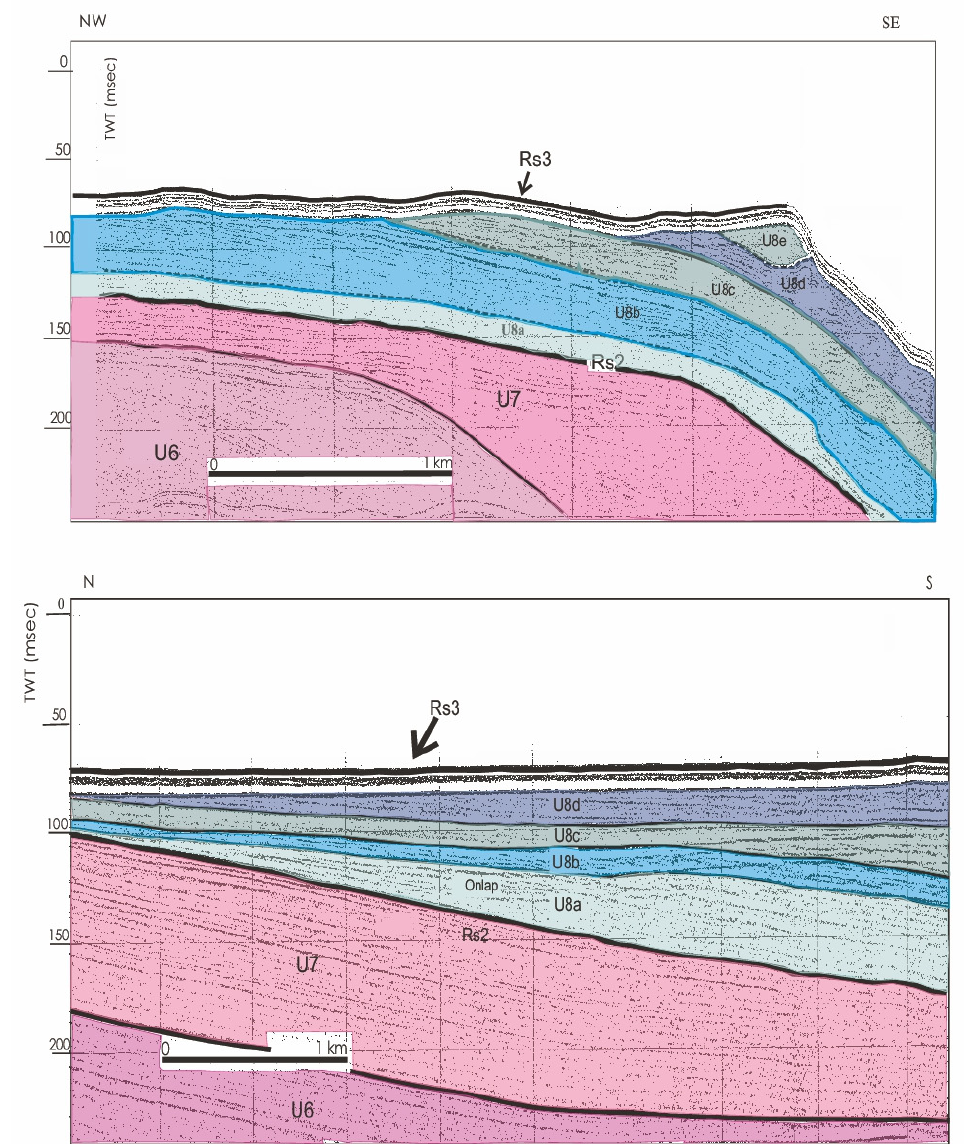
Figure 10. Line drawing of seismic profile showing the stratigraphic architecture of the post-125- ky prograding wedge (W3); modified after [3]. It represents a 4th-order incomplete depositional sequence, well preserved and developed at the shelf margin (see the upper sketch section). A transgressive unit onlapping the RS2 (U8a) has been recognized, while lowstand and forced regression deposits are represented, respectively, by the units U8b–U8c and by the units U8d–U8e.